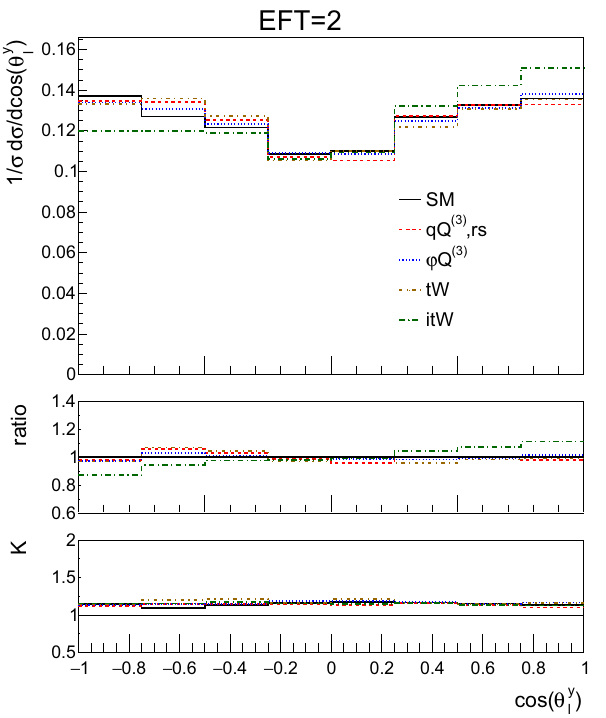
in the first inset is defined as the effect of the operator over the SM, the second inset shows the K -factor. Here additional cuts are applied on > 10 GeV and | η l | < 2 . 47 and jets: p j > 20 GeV and the leptons: p l T T | η j | < 4 .